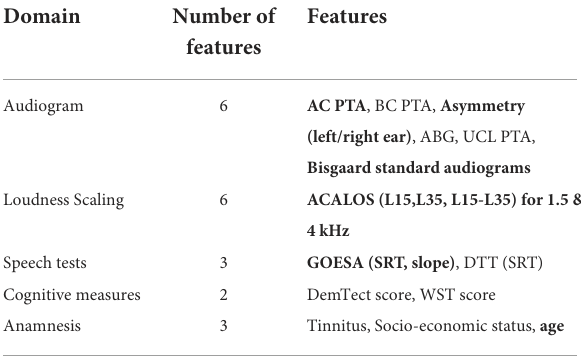
TABLE 1 Overview of audiological domains and features used for the generation of the